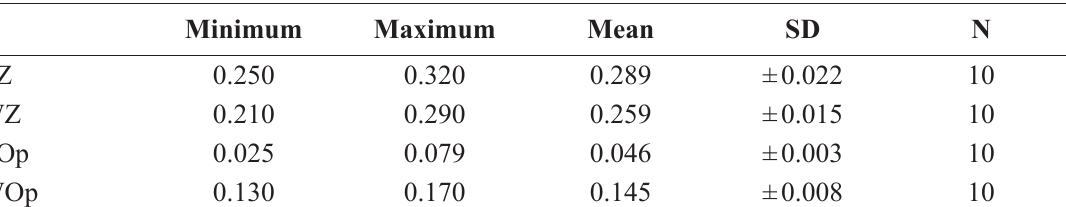
Table 3. Measurements in mm of Antropora ramaniaensis sp. nov., holotype (GIS/B 0440), Burdigalian, lower Miocene, Chhasra Formation, western Kachchh, Gujarat, India. Abbreviations: see Material and methods.